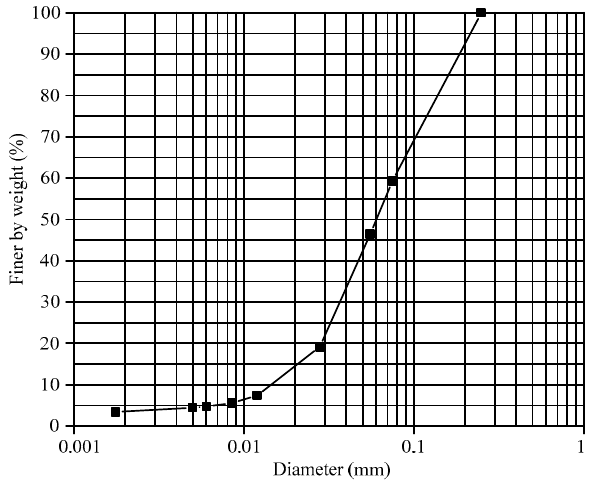
Figure 3. Idealized stress and strain components within HCA subjected to axial and torsional loads. ( a ) The HCA can cyclically and independently control the vertical/torque load (W/M T ) and outer/inner cell pressure p o /p i ; ( b ) The stress components of σ z , σ r , σ θ , and τ z θ in an element of a hollow cylinder specimen; ( c ) The stress components of σ 1 , σ 2 and σ 3 in an element of a hollow cylinder specimen.